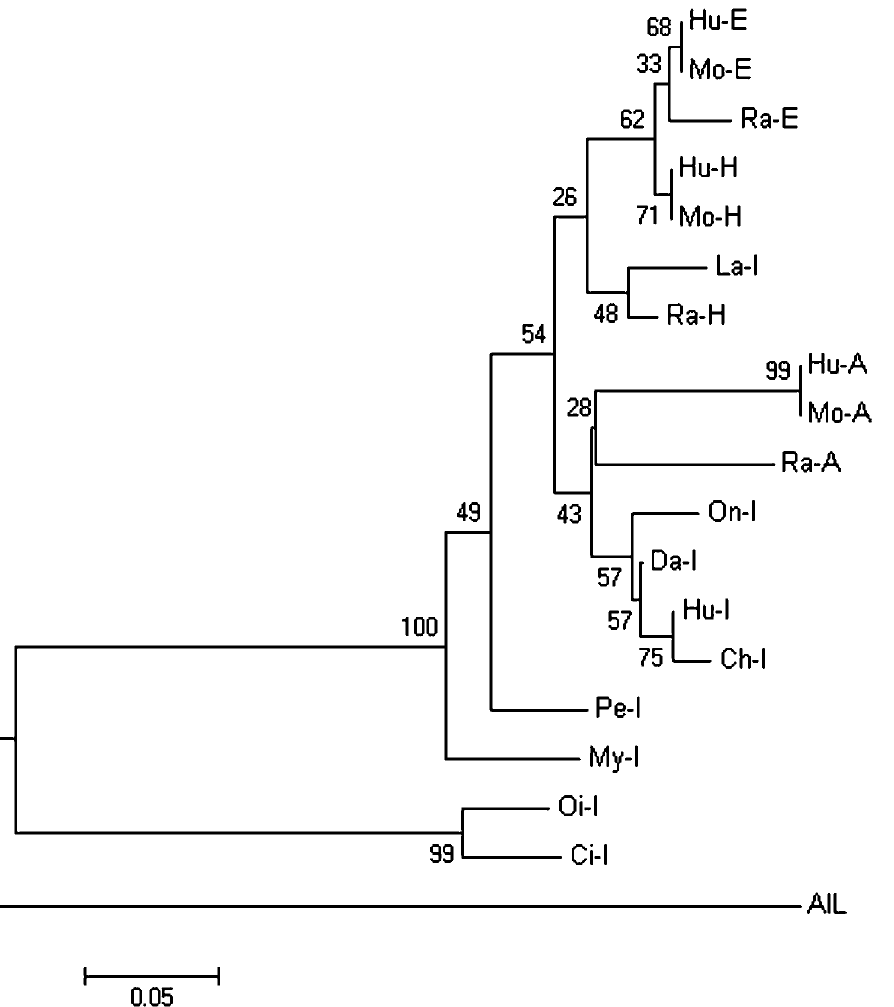
Figure 4. Neighbor-joining tree of ikaros proteins. The tree is based on the amino acid alignment in Figure. 3. Numbers on the branches indicate bootstrap values. The tree is rooted at midpoint.